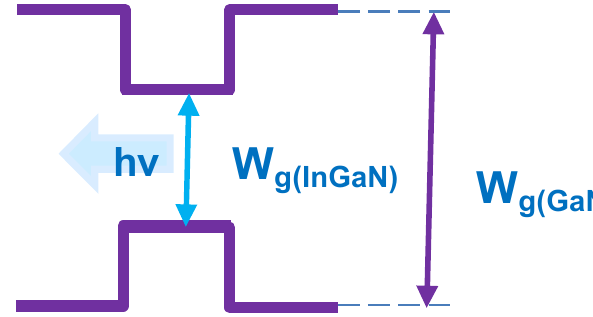
Figure 5. A band diagram of the quantum well structure.